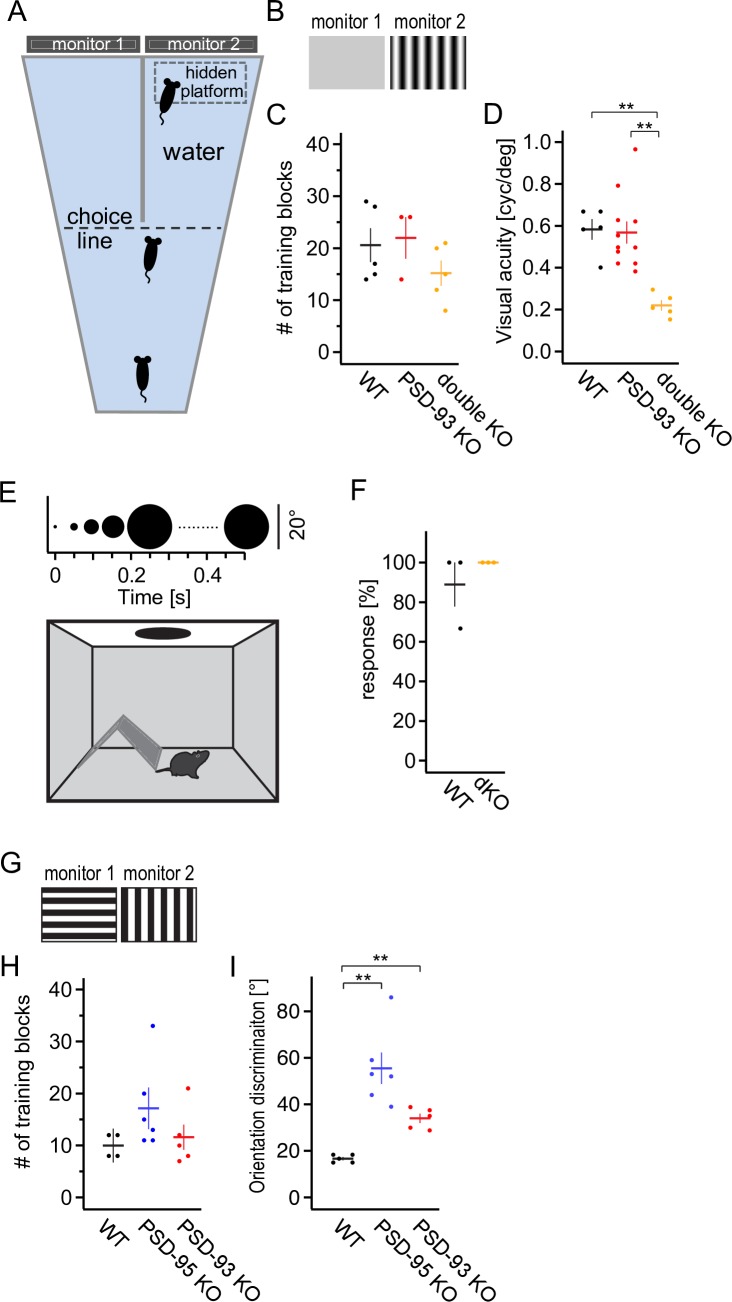
Acquired, but not innate, visual capabilities are impaired by loss of the DLG-MAGUK paralogs.(A, B) Scheme of the VWT apparatus (A) showing the trapezoid water-filled pool, the midline divider, choice line, and the monitors on which visual stimuli are projected. For measuring visual acuity, mice were trained to swim towards the sinusoidal vertical grating (B; rewarded stimulus). For measuring orientation discrimination, mice were trained to swim towards square-wave vertical grating (G; rewarded stimulus), and the initial horizontal grating was turned by 5° per trial to approach the vertical orientation. (C, H) Number of training blocks to learn the visual acuity procedure (C) for WT, PSD-93 KO, and PSD-93/95 dKO mice or orientation discrimination procedure (H) for WT, PSD-95 KO, or PSD-93 KO mice. Values of individual mice are presented as dots and mean as horizontal line. Underlying data for this figure can be found in S1 Data. (D, I) Visual acuity (D) or orientation discrimination (G) threshold for indicated mouse groups. **p < 0.01. Underlying data for this figure can be found in S1 Data. (E) Schematic representation of the looming procedure with a mouse in a dark arena with a shelter hut and a bright ceiling, on which the dark looming spot is presented. Time course of looming spot presentation is illustrated at the top. (F) The fraction of responses of three consecutive trials (24 h apart) is plotted against WT and PSD-93/95 dKO mice. Values of individual mice are presented as dots and mean as horizontal line. **p < 0.01. Underlying data for this figure can be found in S1 Data. dKO, double KO; DLG, disc-large; KO, knock-out; MAGUK, membrane-associated guanylate kinase; PSD, postsynaptic density; VWT, visual water task; WT, wild-type.